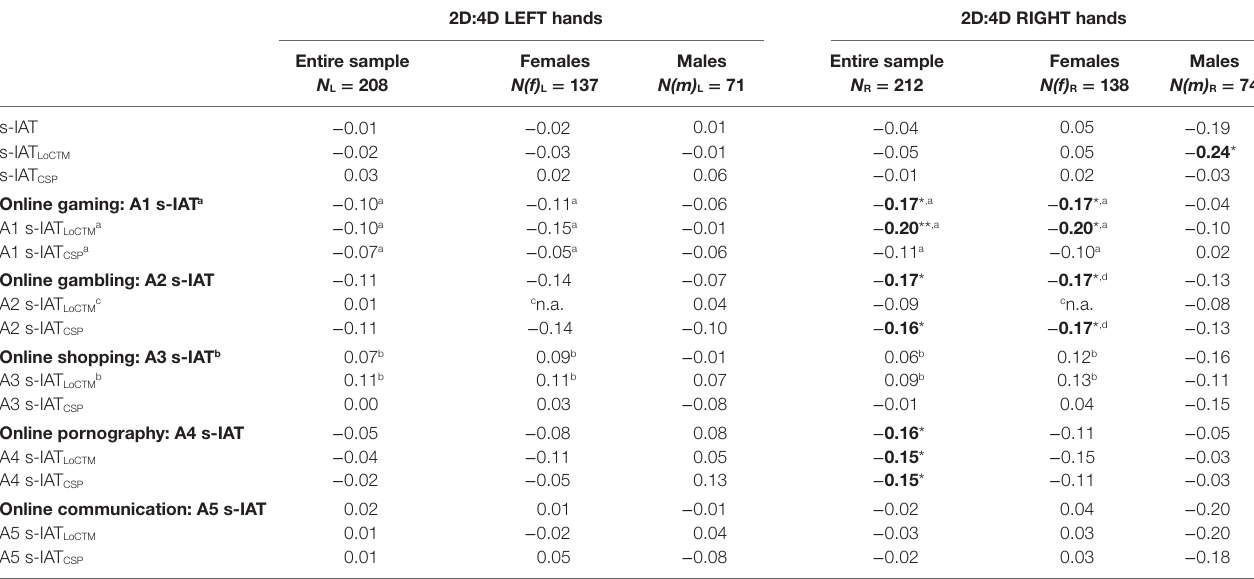
Correlation (2-tailed) is significant at the 0.01 level (**), at the 0.05 level (*); sub-facets of s-IAT: LoCTM, loss of control/time management; CSP, craving/social problems; s-IAT A1 to s-IAT A5 scales. a N is reduced by 1 (one female participant did not provide information for online gaming): for LEFT hands N L = 207, N(f) L = 136; for RIGHT hands N R = 211, N(f) R = 137. b N is reduced by 1 (one female participant did not provide information for the 3rd item of online shopping, A3 s-IAT CSP remains unaffected): for LEFT hands N L = 207, N(f) L = 136; for RIGHT hands N R = 211, N(f) R = 137. c All female participants chose the lowest value: M = 2, SD = 0. d p = 0.05. Significant findings are displayed in bold letters.